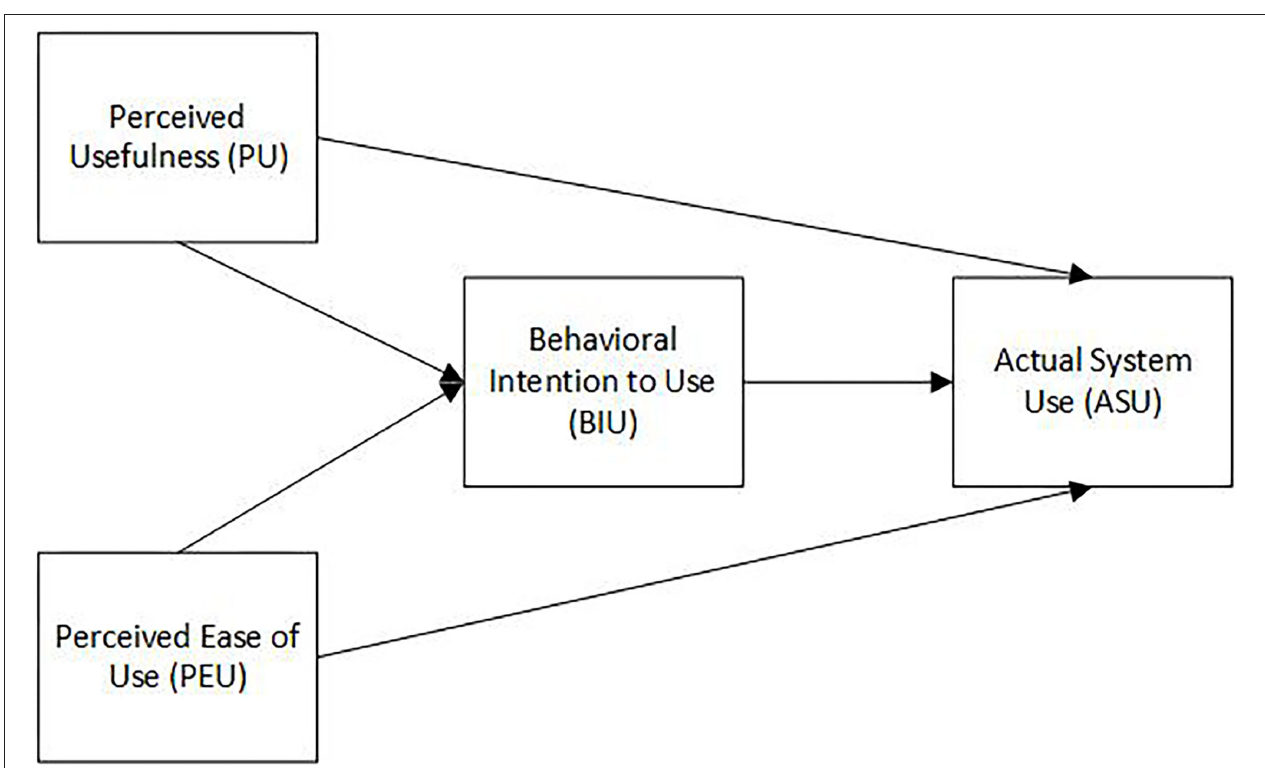
FIGURE 1 | Theoretical